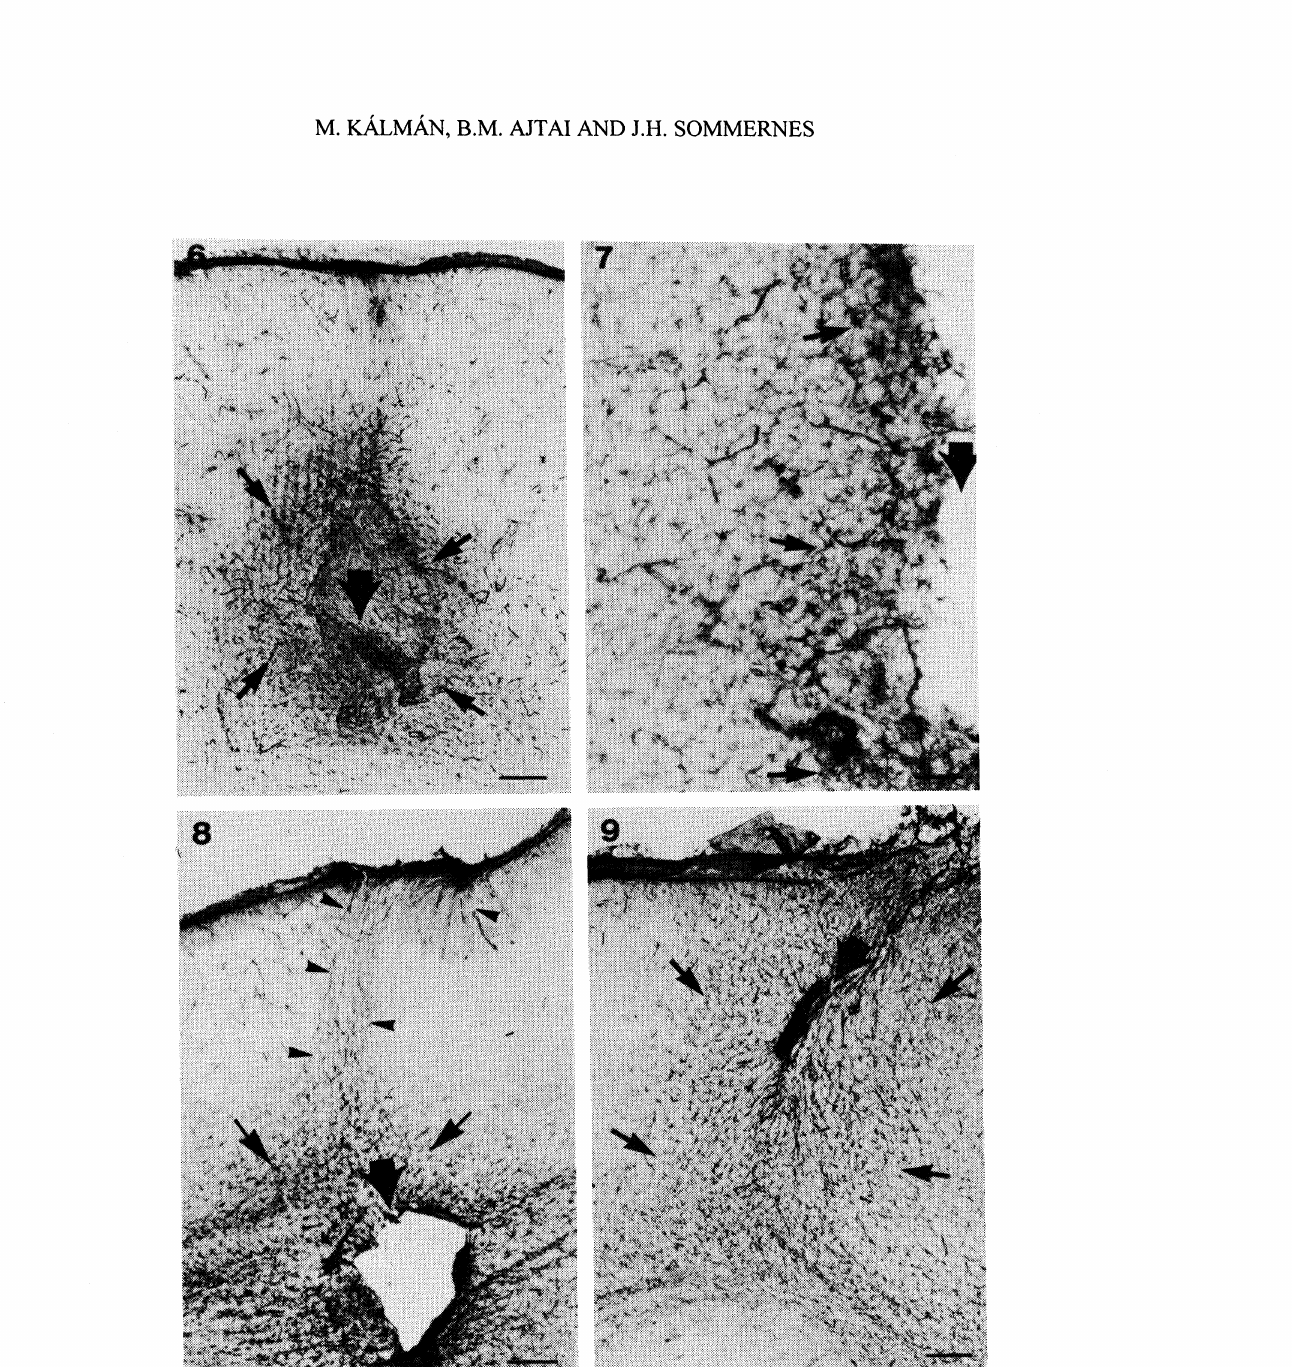
GFAP immunostaining of glial reactions following P0 lesions. (6) Severe-type P0 lesion, post-op d-30. Strong reactive gliosis (arrows) are found around the lesion (thick arrow), proving that the glial reaction to P0 lesions is not a transient phenomenon. This figure is a lower magnification than the others, to show an adequate part of the cortex, which is already thicker at this age. Bar lesion, similar to that shown in Fig. 6, shows reactive astrocytes (arrows) around the lesion (thick arrow). Bar 80 lam. GFAP immunostaining of glial reactions following P2 lesions. (8) Severe-type P2 lesion, post-op d-4. The site of the lesion (thick arrow) is recognizable by the tissue defect. A weak glial reaction is detected only in the depth of the cortex (arrows), whereas the superficial part of the lesion (arrowheads) is not surrounded by reactive glia. Bar 200 lam. (9) Severe-type P2 lesion, post-op d-6. Strong glial reaction (arrows) can be detected along the lesion (thick arrow) up to the surface ofthe cortex. Bar 200